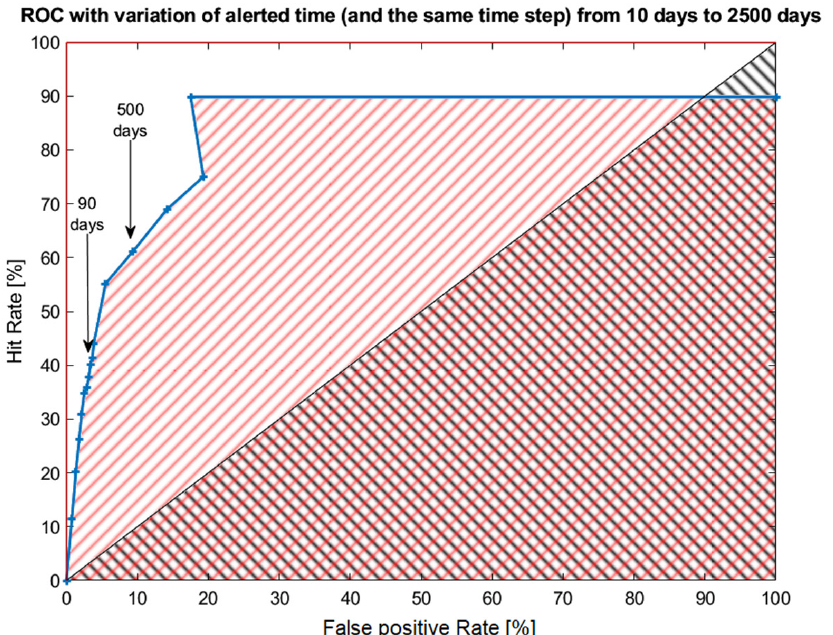
Figure 5. Receiving Operating Characteristic (ROC) graph for the best Swarm magnetic field and electron density anomalies (i.e., the ones in WSC concentrations with significant statistical parameters d ≥ 1.5 and n ≥ 4.0) calculated, varying the alerted time from 10 days to 2500 days. The Area Under the Curve (AUC) is represented as a black dashed pattern for a random case and as a red dashed pattern for the real Swarm case.